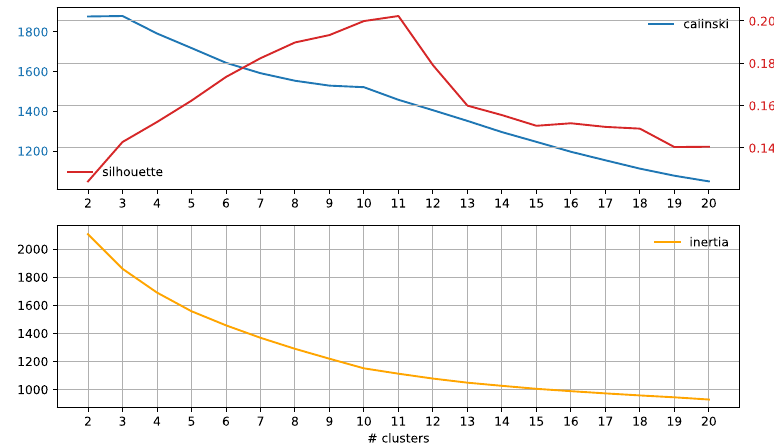
Figure A13. Subreddit ChronicIllness.